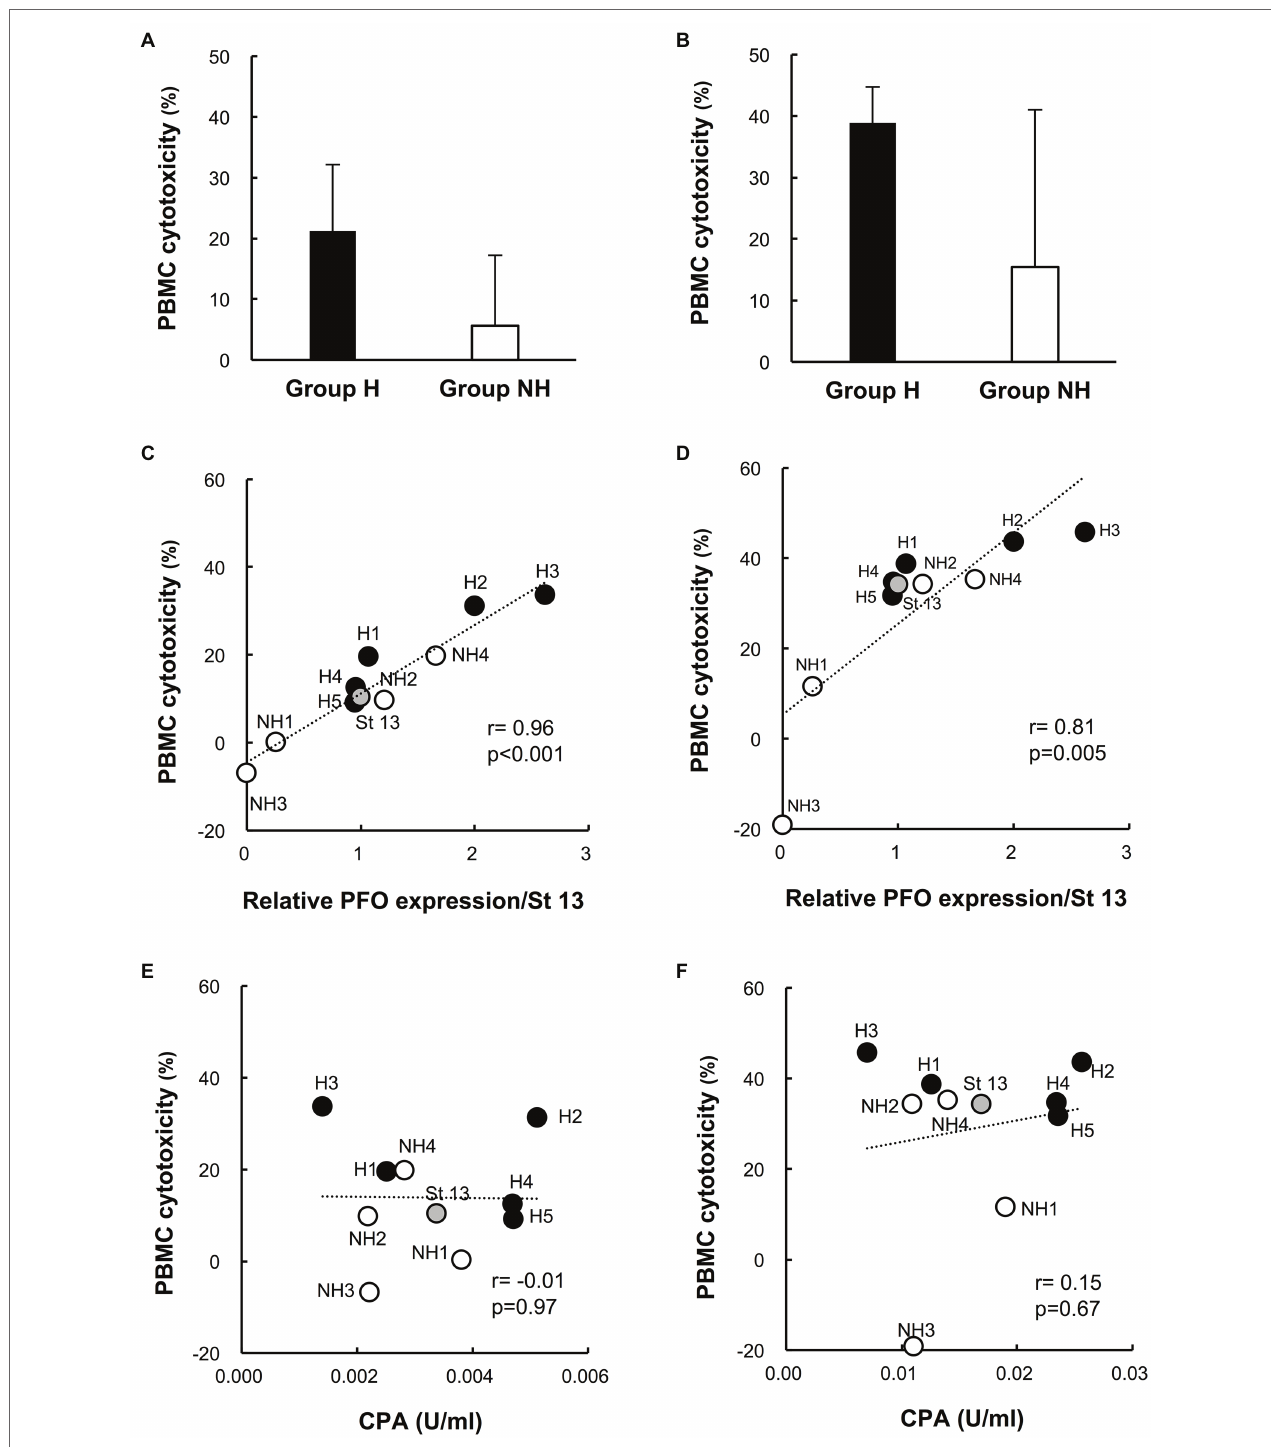
FIGURE 3 | Cytotoxicity of culture supernatants of clinical isolates in human peripheral blood mononuclear cells (PBMCs). (A) Cytotoxicity of 1% culture supernatants from group H ( n = 5) and group NH ( n = 4) strains in human PBMCs for 4 h. (B) Cytotoxicity of 5% culture supernatant in human PBMCs for 4 h. The values are the average of five independent experiments conducted with technical triplicates, and the error bars indicate the SDs. (C) Correlation between cytotoxicity in human PBMCs and PFO production in 1% culture supernatants. The average cytotoxicity in PBMCs from five healthy donors is plotted against the relative PFO expression normalized to that of strain 13. (D) Correlation between cytotoxicity in human PBMCs and PFO production in 5% culture supernatants. (E) Correlation between cytotoxicity in human PBMCs and CPA production in 1% culture supernatants. The average cytotoxicity in PBMCs from five healthy donors is plotted against the CPA concentration. (F) Correlation between cytotoxicity in human PBMCs and CPA production in 5% culture